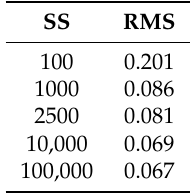
Table 2. Root mean square (RMS) values for the best fit functions (corrected for synthetic true) computed for different sample size (SS) in the joint